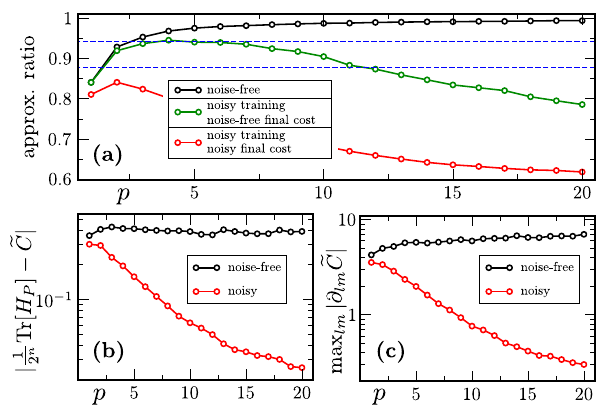
Fig. 3 QAOA heuristics in the presence of realistic hardware noise: increasing number of rounds for fi xed problem size. a The approximation ratio averaged over 100 random graphs of 5 nodes is plotted versus number of rounds p . The black, green, and red curves respectively correspond to noise-free training, noisy training with noise-free fi nal cost evaluation, and noisy training with noisy fi nal cost evaluation. The performance of noise- free training increases with p , similar to the results in Ref. 15 . The green curve shows that the training process itself is hindered by noise, with the performance decreasing steadily with p for p > 4. The dotted blue lines correspond to known lower and upper bounds on classical performance in polynomial time: respectively the performance guarantee of the Goemans- Williamson algorithm 77 and the boundary of known NP-hardness 78,79 . b The deviation of the cost from Tr ½ H P (cid:4) = 2 n (averaged over graphs and parameter values) is plotted versus p . As p increases, this deviation decays approximately exponentially with p (linear on the log scale). c The absolute value of the largest partial derivative, averaged over graphs and parameter values, is plotted versus p . The partial derivatives decay approximately exponentially with p , showing evidence of Noise-Induced Barren Plateaus (NIBPs).